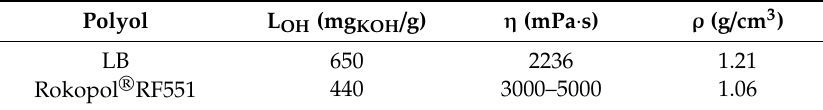
Table 1. Selected properties of polyols used to obtain polyurethane (PU)